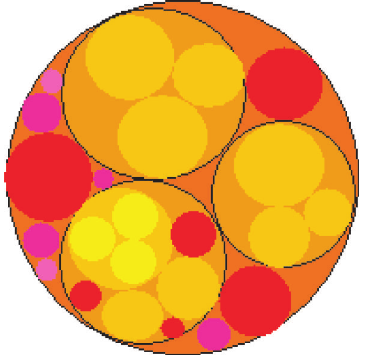
Figure 3.7. Sketch of the Leibniz packing.